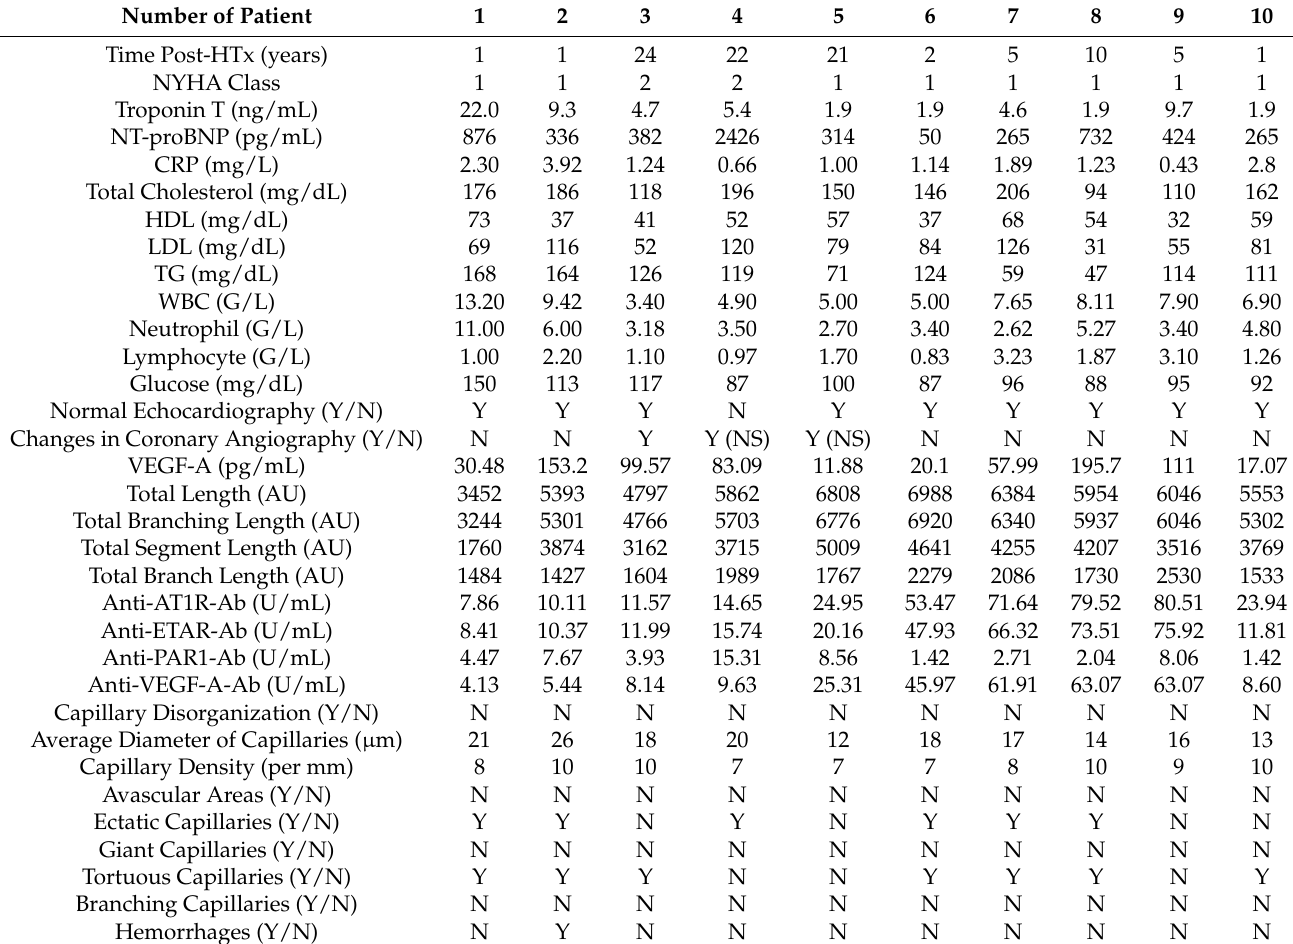
Table 6. Overview of assessed parameters in the individuals of the HTx